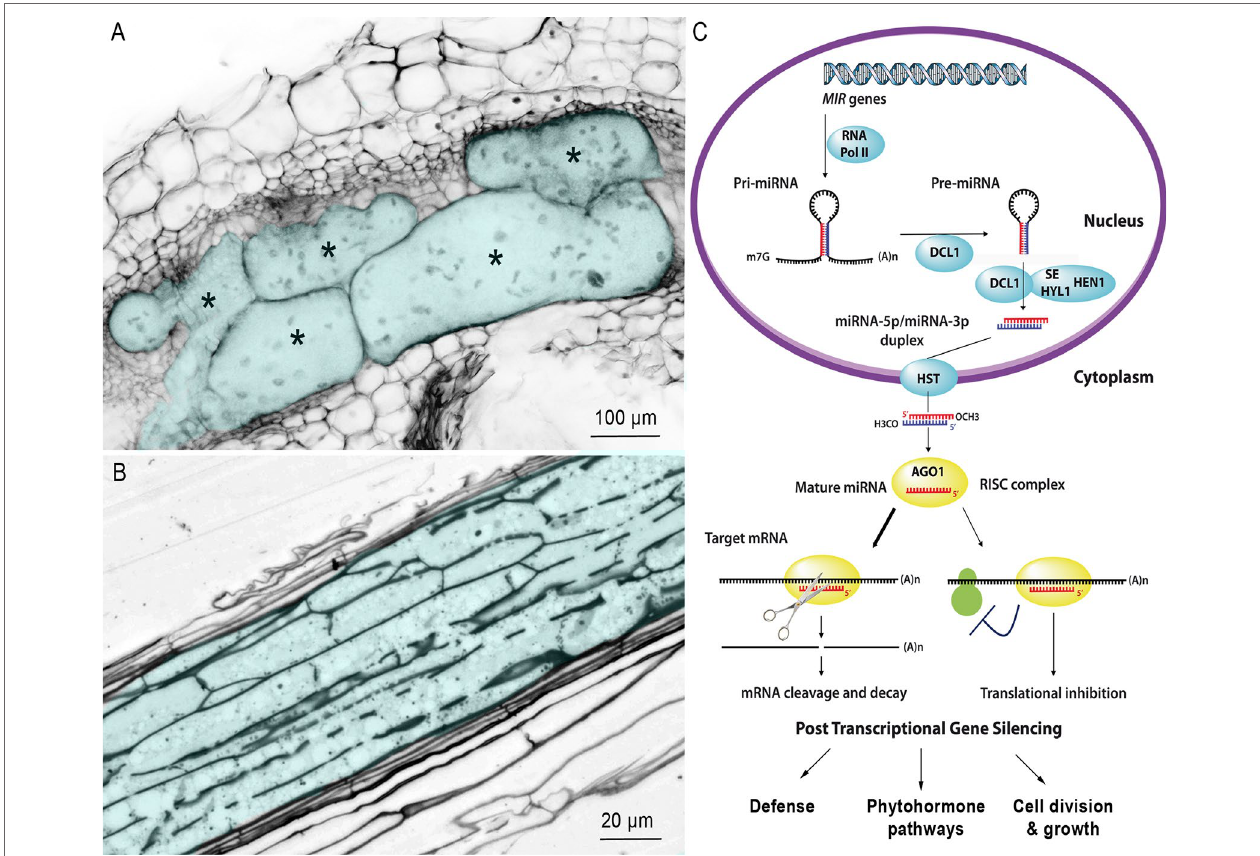
FIGURE 1 | Multinucleate and hypertrophied feeding cells induced by RKN and CN. (A) Confocal section of a gall induced by M. incognita in Nicotiana benthamiana. Galls were fixed and cleared with the BABB method described by Cabrera et al. (2018). Giant cells are colored in blue and marked with an asterisk to differentiate them from surrounding cells of normal size. Bar = 100 μm. (B) Longitudinal section of a syncytium induced by the CN H. schachtii in Arabidopsis roots, 10 days after inoculation. The syncytium is colored in blue. Bar = 20 µm. (C) Simplified biogenesis and mechanism of action of miRNAs in plants. The MIR genes are transcribed by RNA polymerase II (RNA Pol II) to generate single-stranded hairpin-containing primary transcripts (pri-miRNA). The pri-miRNA is then cleaved, in the nucleus, by Dicer-like 1 (DCL1), in association with hyponastic leaves 1 (HYL1) and serrate (SE), to produce a precursor miRNA (pre-miRNA). The pre-miRNA is, in turn, cleaved by DCL1 and its cofactors, thus generating a duplex composed of the mature miRNA and its complementary strand. The HUA ENHANCER 1 protein (HEN1) then adds a methyl group to the OH end of each strand of the miRNA duplex, to protect against degradation. The miRNA duplex is then actively transported from the nucleus to the cytosol through interaction with the hasty (HST) exportin. One of the two strands of the duplex is then loaded onto the argonaute 1 (AGO1) protein, the main constituent of the multiprotein RNA-induced silencing complex (RISC). The AGO1-associated strand guides the RISC to target mRNAs by sequence complementarity, resulting in target cleavage or the inhibition of protein synthesis (reviewed by Yu et al.,